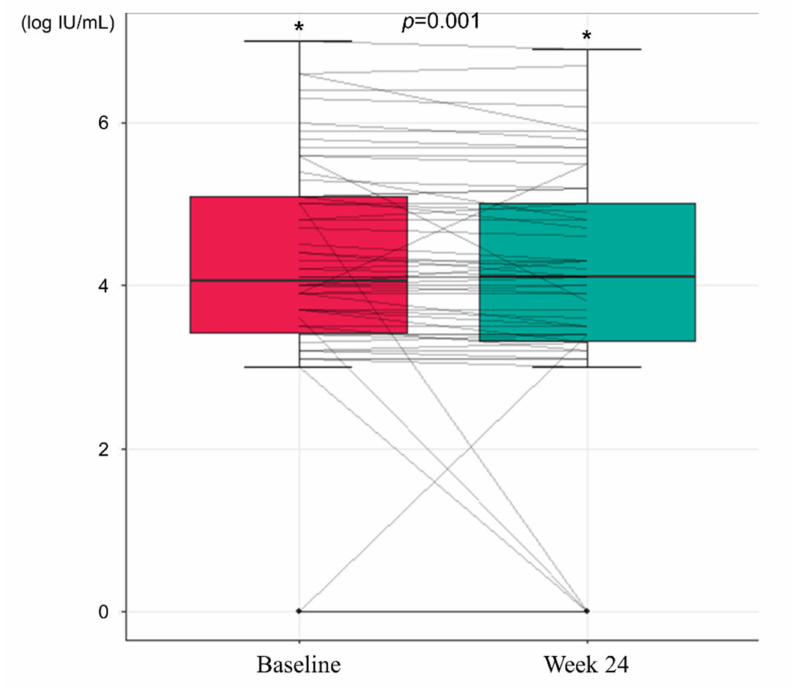
Figure 2. Changes in hepatitis B core-related antigen levels during the study period (* p <